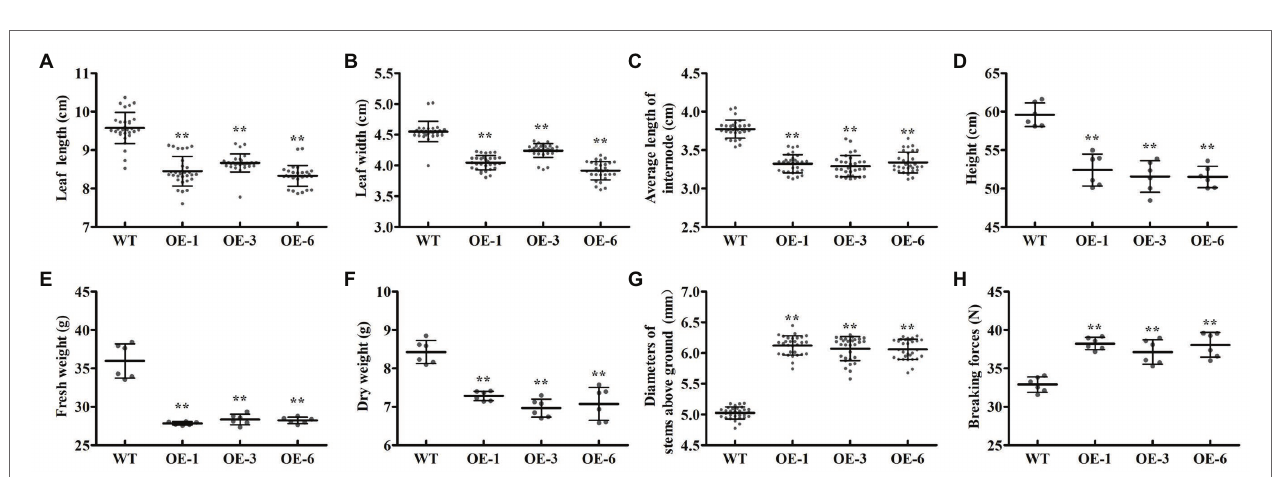
FIGURE 3 | Identification and transgenic lines of PtrGATA12 in P. trichocarpa . (A) PCR detection of PtrGATA12 transgenic lines. M, DNA marker DL5000; 1, positive control; 2–8, PCR products of PtrGATA12 transgenic lines; WT, wild-type P. trichocarpa . (B) qRT-PCR detection of PtrGATA12 transgenic lines. PtrActin was used as a control. Each error bar represents the SD of three biological replicates. Asterisks indicate levels of significance (Dunnett’s test; *, 0.01 < p < 0.05, **, p < 0.01). (C) Three-month-old wild-type (WT) and PtrGATA12 transgenic lines (OE-1, OE-3, and OE-6). Scale bars = 10 cm.